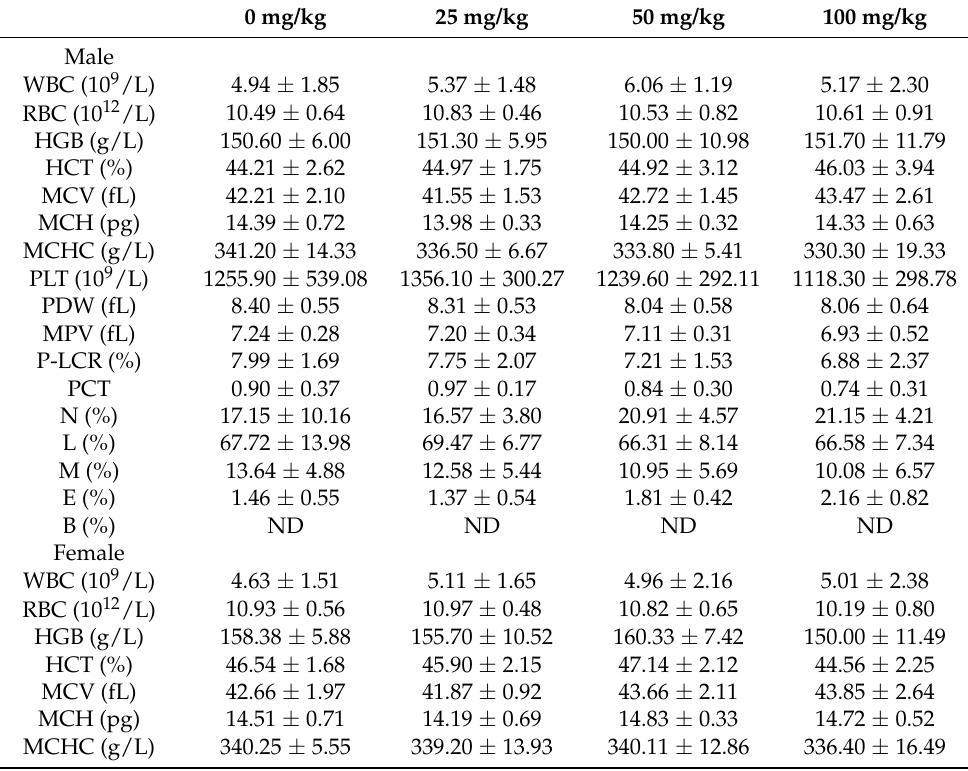
Table 7. Hematological parameters in the repeated-dose 30-day oral toxicity